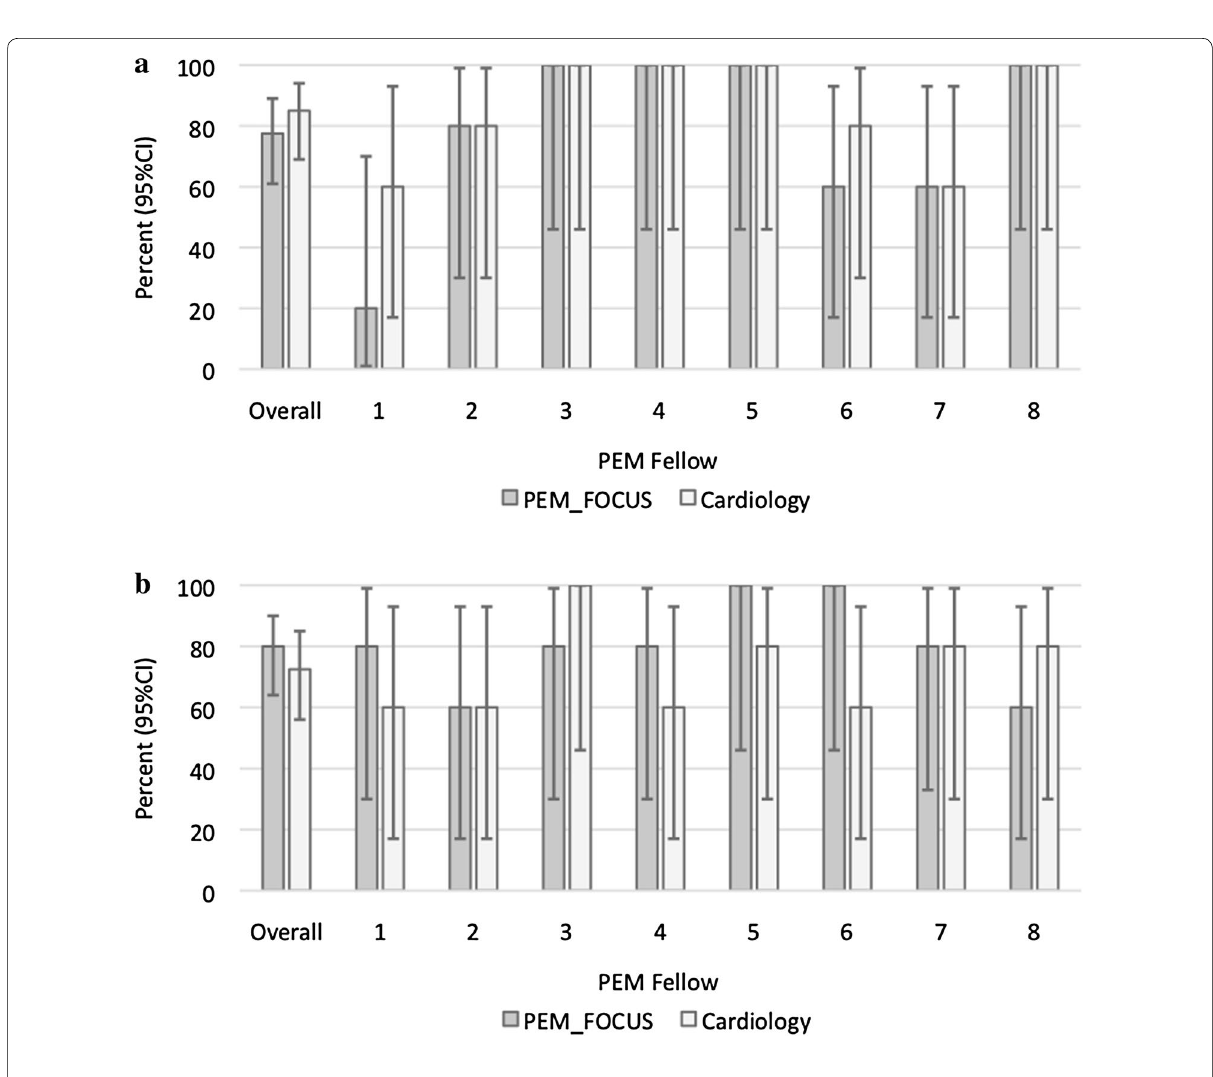
Fig. 3 Sensitivity of interpretation of classroom test of images of PEM FOCUS versus cardiology images by 8 PEM fellows for function ( a ) and effusion ( b